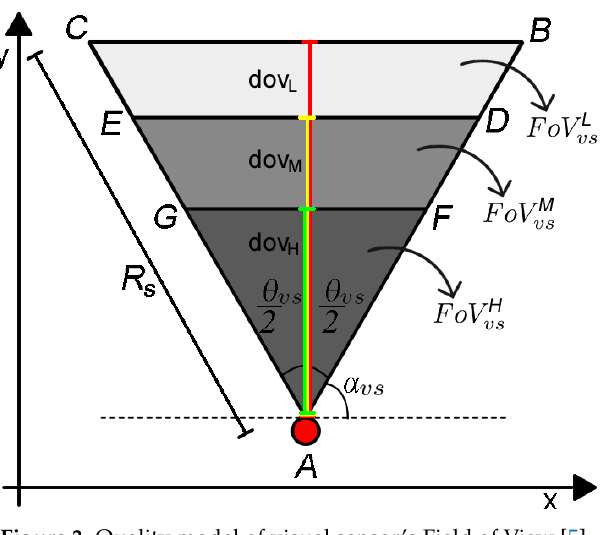
Figure 3. Quality model of visual sensor’s Field of View